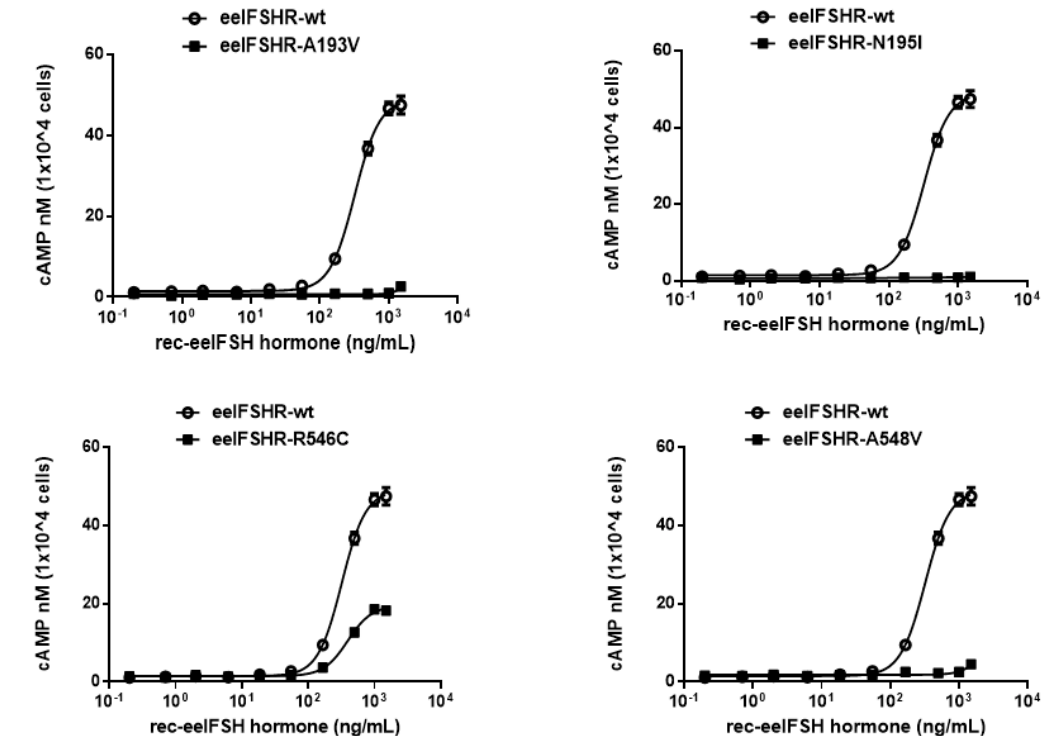
Figure 4. cAMP production stimulated by recombinant eelFSH (rec-eelFSH) treatment in CHO-K1 cells transfected with the inactivating eelFSHR mutants. CHO-K1 cells transiently transfected with wild-type eelFSHR and inactivating eelFSHR mutants (A193V, N195I, R546C, and A548V) were stimulated with rec-eelFSH for 30 min. Total cAMP accumulation was determined by a homogeneous time-resolved fluorescence (HTRF). The empty circles denote wild-type eelFSHR and the black circles denote the mutants. The data were subtracted from the results of the mock-transfected cells. A representative data was obtained from three independent experiments. The blank circles were the same curves of wild-type receptor.